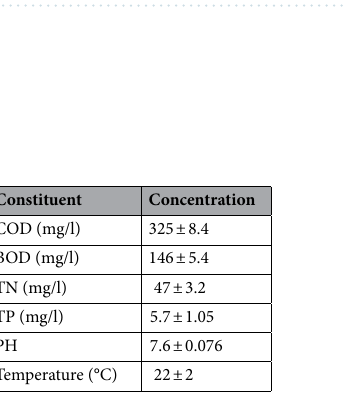
Figure 1. ( a , b ) The original plant setup and the experimental set-up; a: The original system, b: New upgraded IFAS-OSA system (created in Microsoft Word and Paint, link versions 2010&2013).